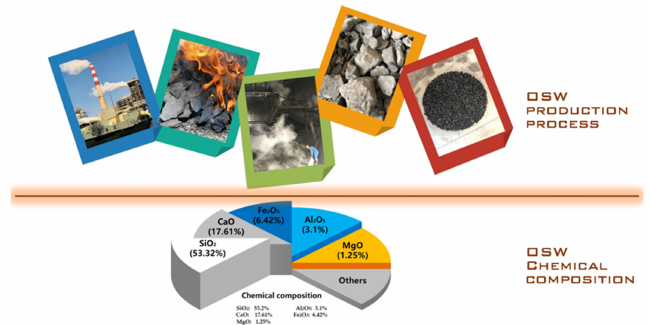
Figure 1. Chemical composition of oil shale waste of Huadian Longteng Power Plant in Jilin Province China. OSW: oil shale waste.